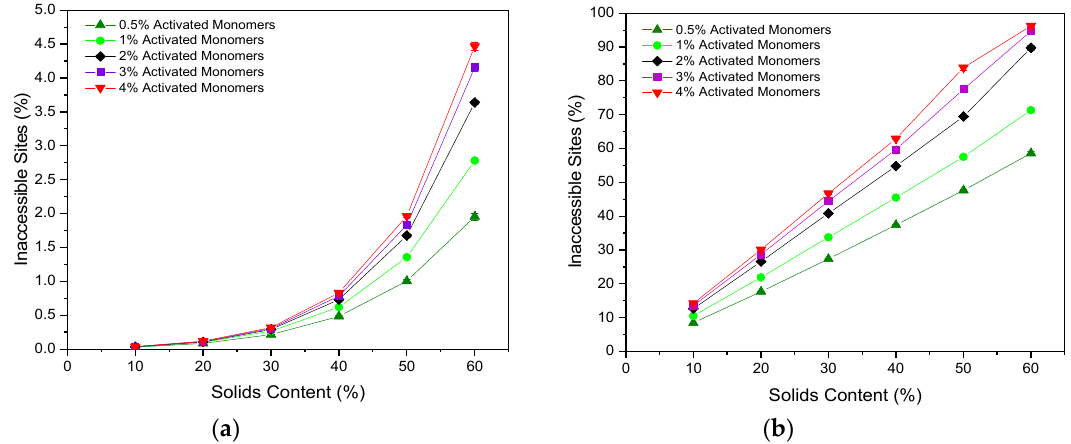
Figure 4. Percentage of inaccessible sites within the lattice with varying solids content ( S c ) and activated monomer ( C c ) values with respect to a di ff using particle of ( a ) Size 1 and ( b ) Size 3. Standard deviation error bars are present around each data point, although may not be visible due to their size relative to the data point marker.